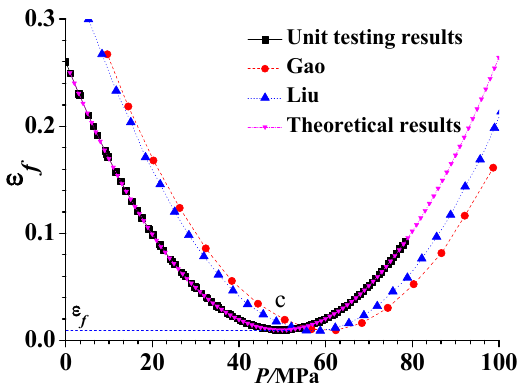
p ε − curves obtained from unit testing and other researchers. Figure 16. Comparison of ε f − p curves obtained from unit testing and other researchers. f